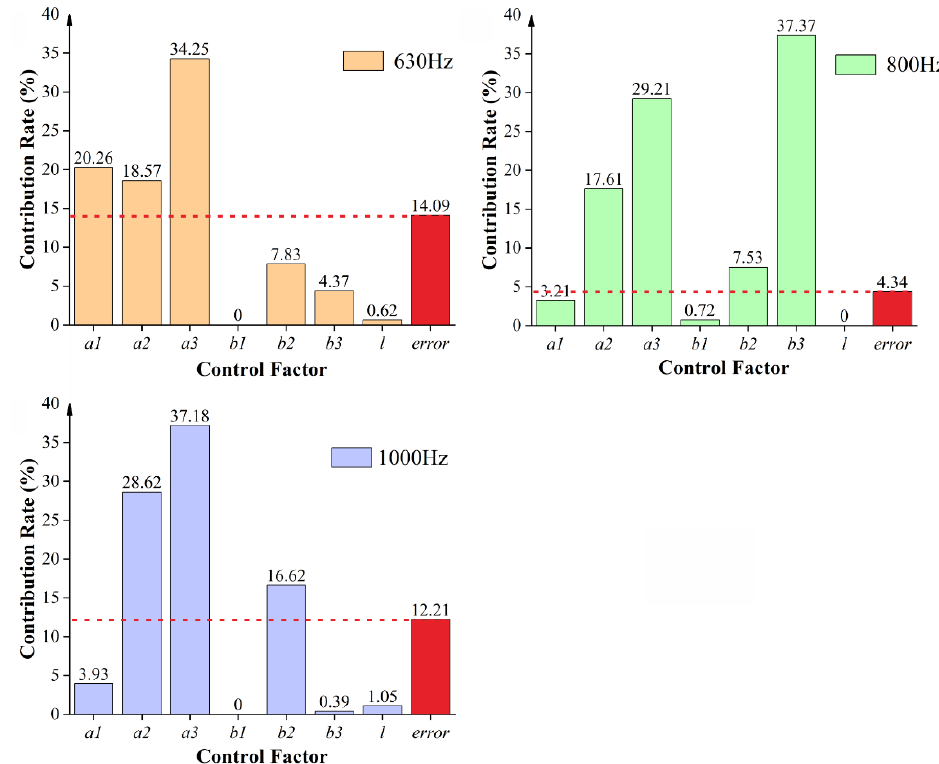
Figure 8. Contribution rates of control factors at different frequencies.